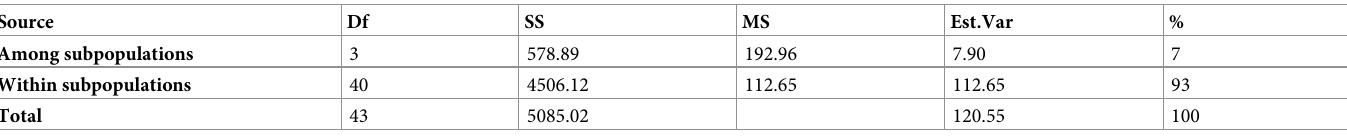
Table 1. Analysis of molecular variance (AMOVA) of the genetic variation among and within the four subpopulations of C . cajan genotypes using the 688 SNPs. Source Df SS MS Est.Var % Among subpopulations 3 Within subpopulations